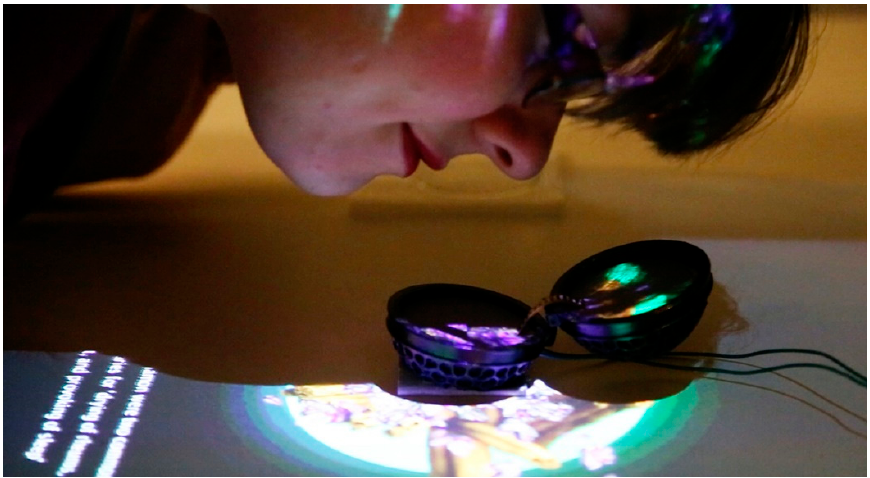
Figure 11. Scents of Power F igure 11. Scents of Power interaction.